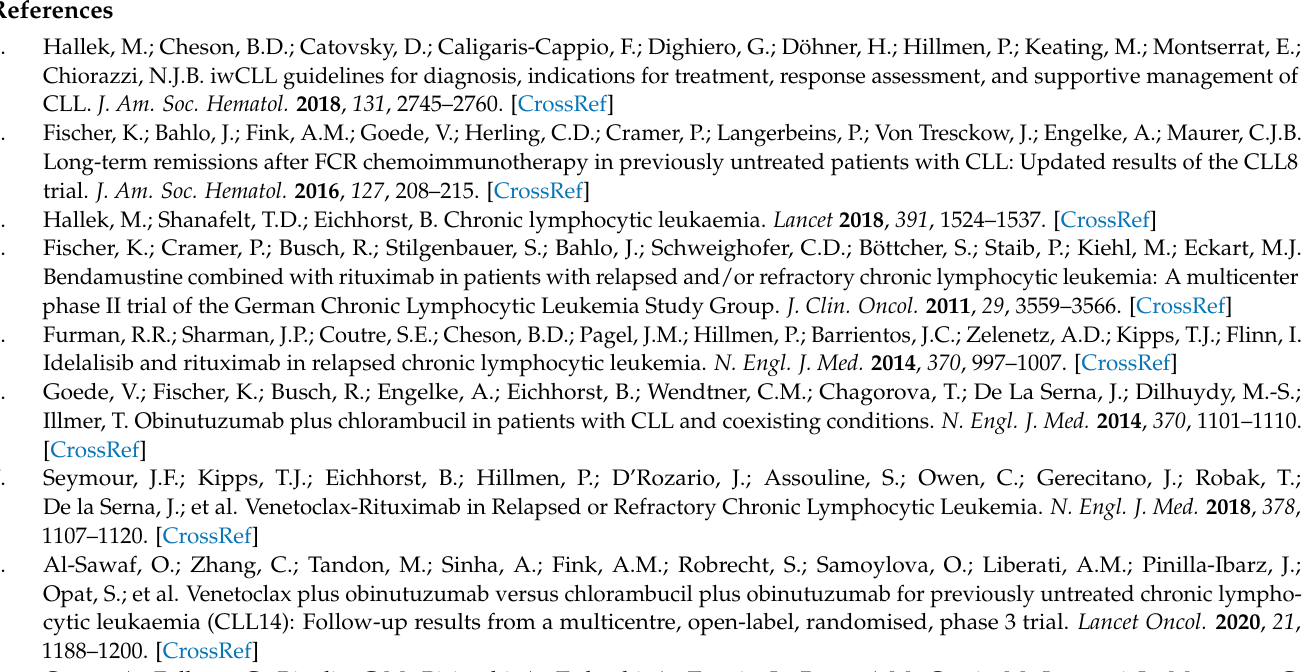
Table S2: Summary of subgroup analysis of progression-free survival; Table S3: Summary of adverse events associated with infusion-related reactions; Table S4: Summary of adverse events associated with secondary primary malignancies; Table S5: PRISMA 2020 checklist; Figure S1: Forest plot for time to next treatment [30,42]; Figure S2: Forest plot for progression-free survival (subgroup different generation BTK inhibitors) [25,30,42,45]; Figure S3: Forest plot for overall survival (subgroup different generation BTK inhibitors) [25,30,42,45]; Figure S4: Pooled risk ratios for overall response (A) and complete response (B) (subgroup different generation BTK inhibitors) [25,30,42,45]; Figure S5: Pooled risk ratios for grade ≥ 3 adverse events